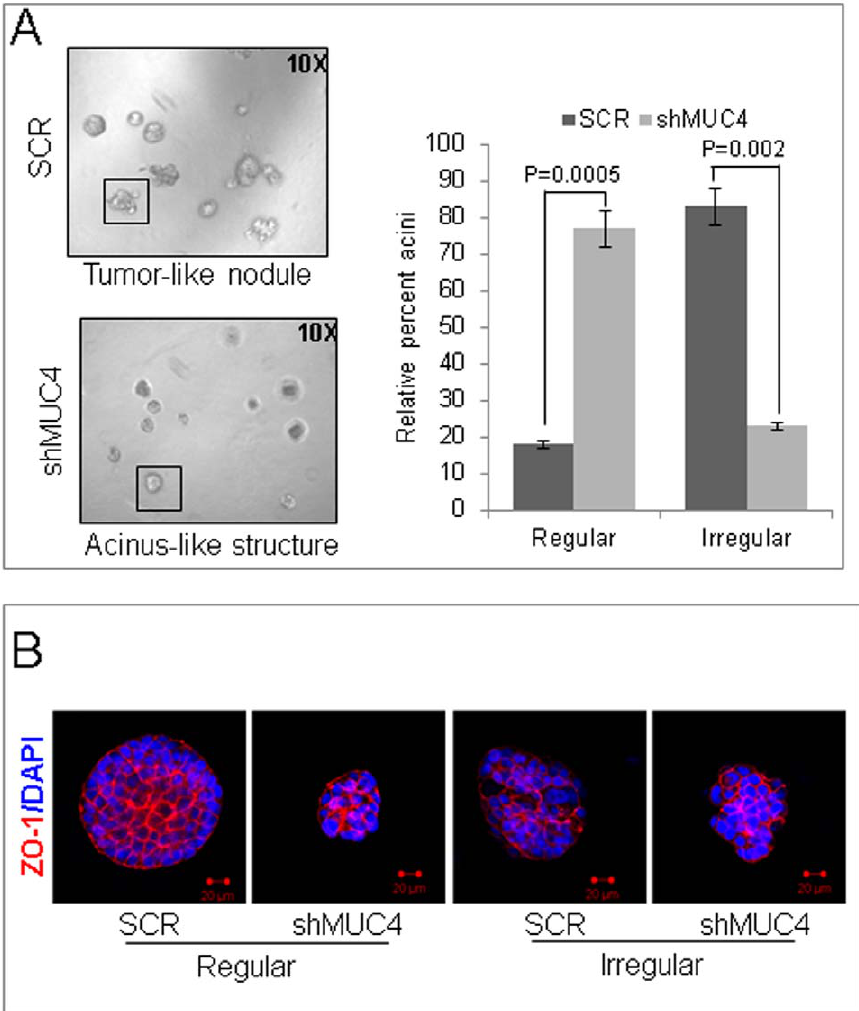
Figure 4. MUC4 contributes to a altered phenotype. ( A ) The control or MUC4 knockdown cells were seeded in 2% Matrigel on top of a 100% Matrigel layer, and fed with media every 3 days. After 7 days, acini-like structures were photographed under a phase-contrast microscope. The acini- like structures (examples shown in the boxes) that were regular (smooth and spherical shape) or irregular (irregular outline, multi-lobular) were counted and plotted as a percentage of the total count (p=0.0005 for regular and p=0.002 for irregular). A minimum of 120 structures was counted for each of control cells or MUC4 knockdown cells. Reduced irregular outline, multi-lobular and increased smooth and spherical shape colonies were found in MUC4 knock down cells when compared with control cells. ( B ) Structures were stained with the anti-ZO-1 antibody. 4,6-diamidino-2- phenylindole (DAPI) was used for nuclei staining. Optical sections (0.7–0.9 m m) were captured using a laser scanning confocal microscope. The images presented here are the central planes of the acini. Bar=20 m